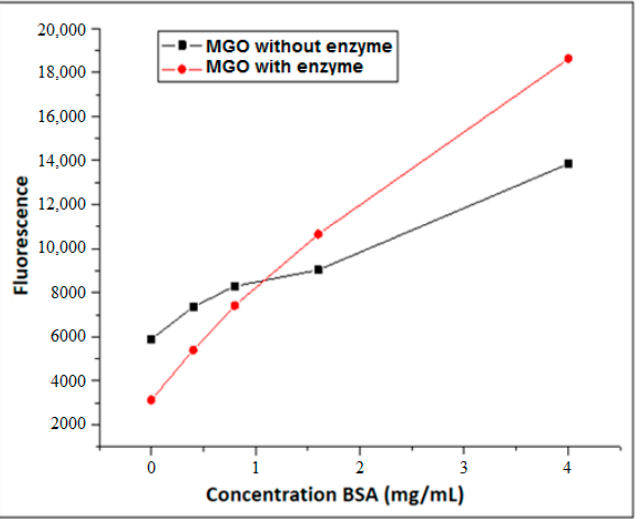
Figure 6. Formation of AGEs using MGO (37 °C) in the presence or absence of XO in pure phosphate buffer (pH = 6.6) with 1 h incubation and varying concentrations of BSA (0–4 mg/mL).